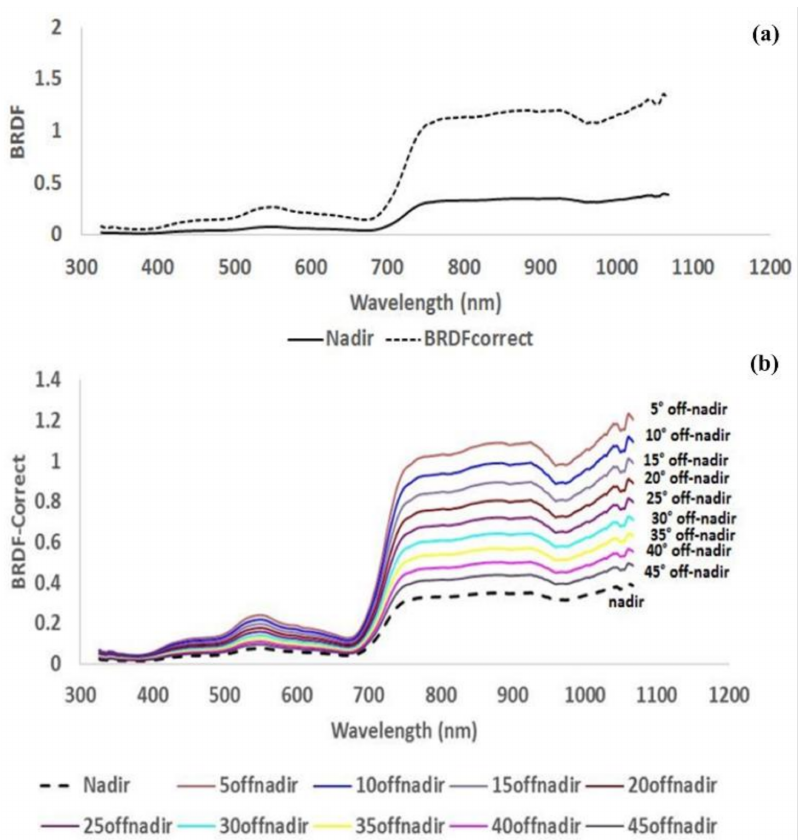
Figure 6. The different viewing angles of sugarcane crops (contributed by Moriya et al. [136]). ( a ) Comparison between spectral signature profile at nadir viewing and the BRDF model curve modified from Walthall’s study. ( b ) Spectral reflectance at ten viewing angles calculated from Walthall’s BRDF correction